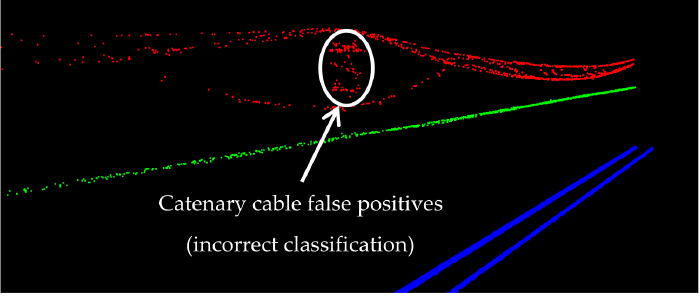
Figure 17. False positives in the classification results of catenary cables at their intersection with